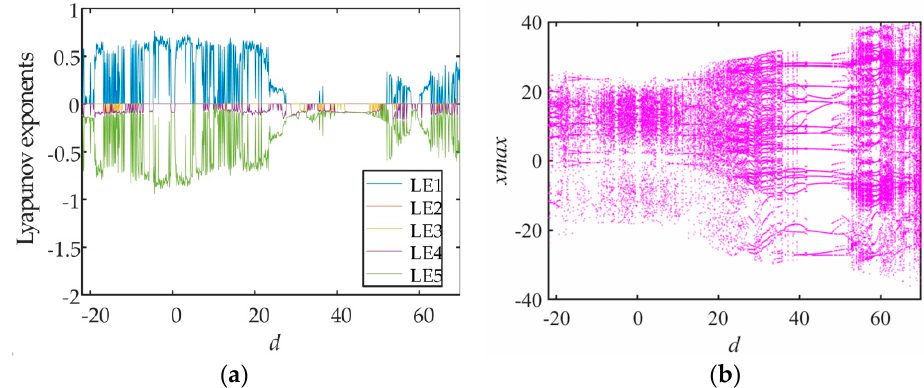
Figure 8. Lyapunov exponent spectrum and bifurcation diagram with parameter d , ( a ) Lyapunov exponent spectrum, ( b ) bifurcation diagram.